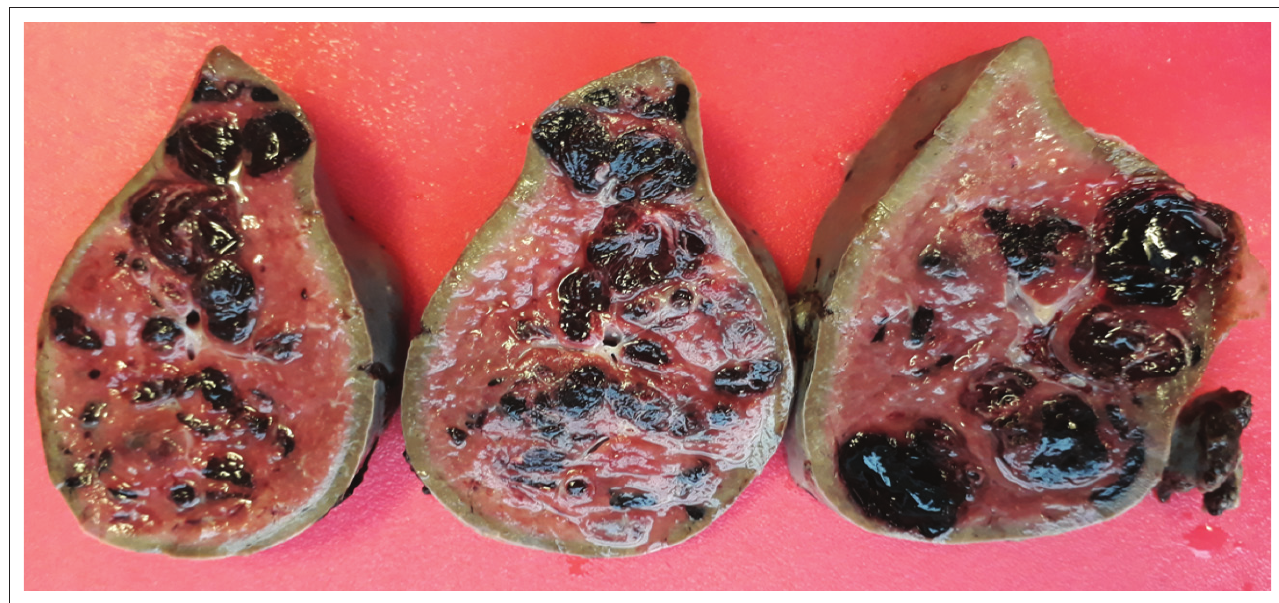
Source: Image taken by Dr Roland Lass. FIGURE 3: Pathology, cut specimen of the splenic parenchyma characterised by multiple blood-filled cyst-like lesions of varying sizes within the splenic